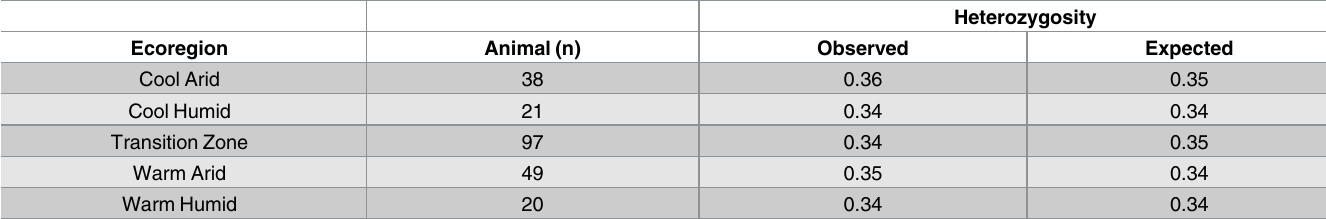
Table 3. Observed and expected heterozygosity estimatesfor Hereford cattle in five ecoregion using 14,312 SNP